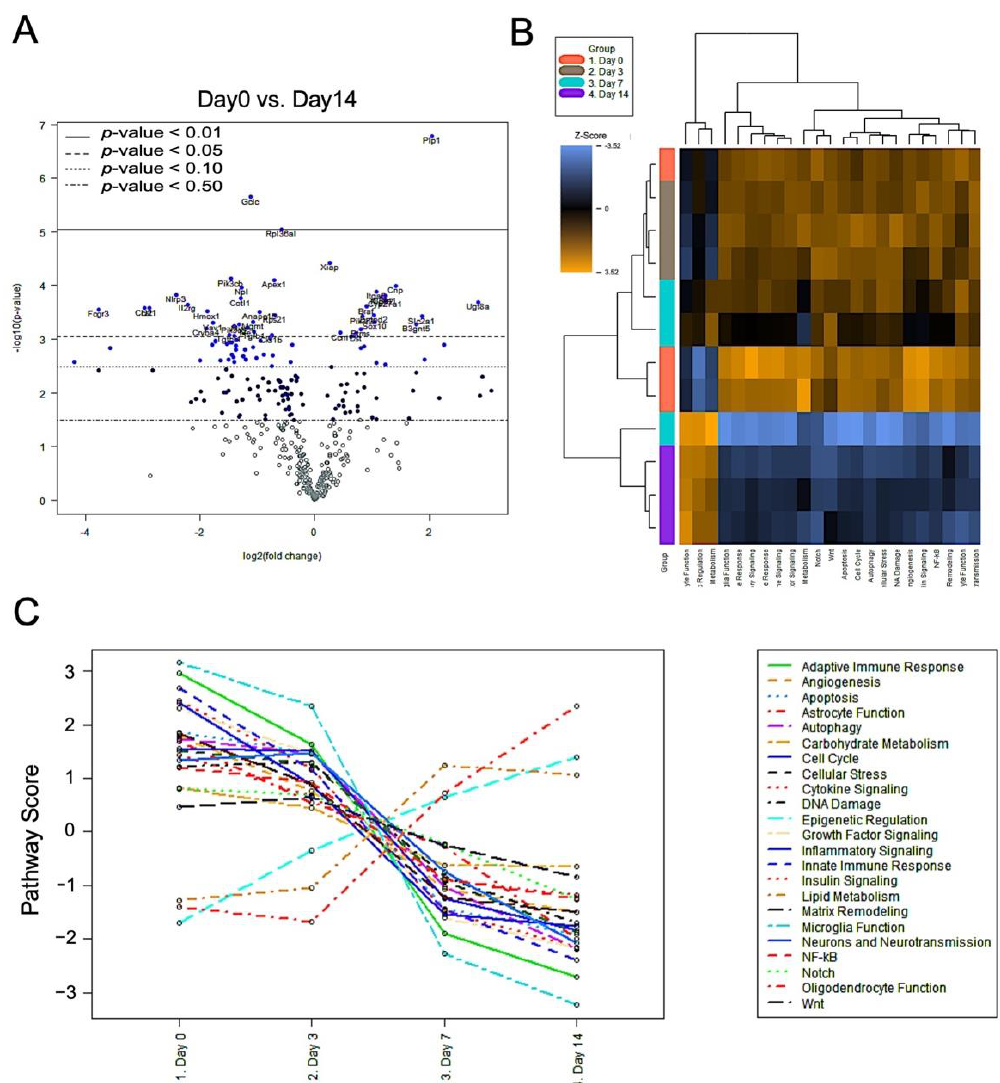
Figure 6. Genetic profiling of injured nerve by NanoString nCounter Neuroinflammation panel. ( A ) Volcano plot demonstrated distribution pattern of both upregulation and downregulation among established neuroinflammation panel, comparing post nerve release day 0 versus day 14. ( B , C ) Heat map distribution of 23 neuroinflammation pathways and processes among post nerve release day 0 to day 14. Significant upregulation of 20 inflammatory pathway in day 0–7, with downregulation at day 14. Reverse pattern presented among three pathways, including oligodendrocyte function, epigenetic regulation, and lipid metabolism. (n = 3 for each group).